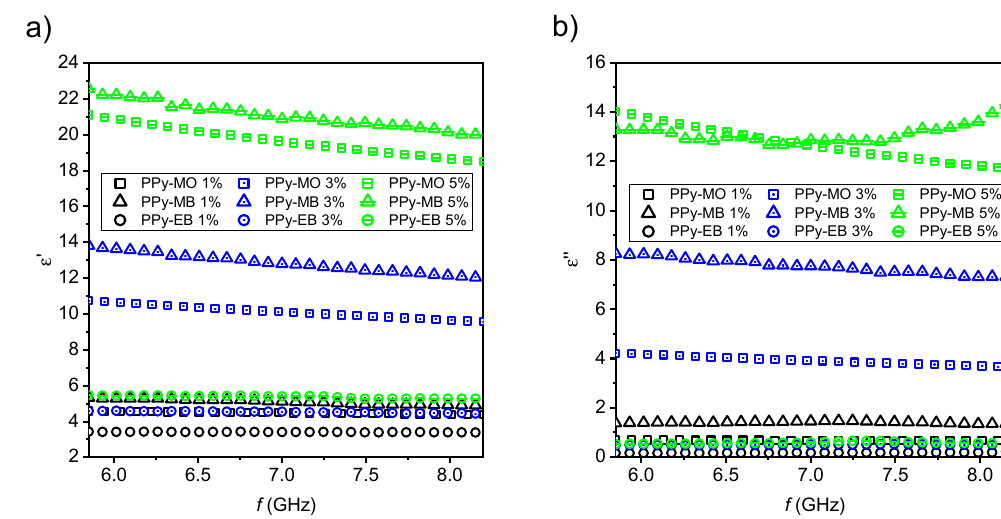
Figure 5. Real ( a ) and imaginary ( b ) parts of complex permittivity of PPy 1D samples prepared at 25 °C, various loadings.